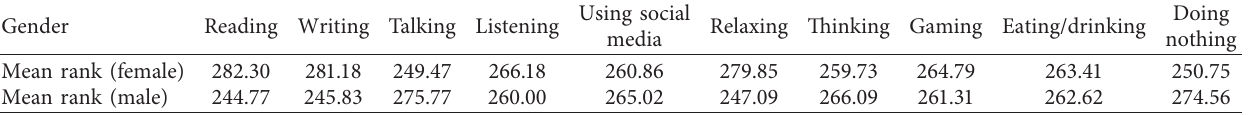
Table 12: One-way ANOVA/ranks of the gender groups.